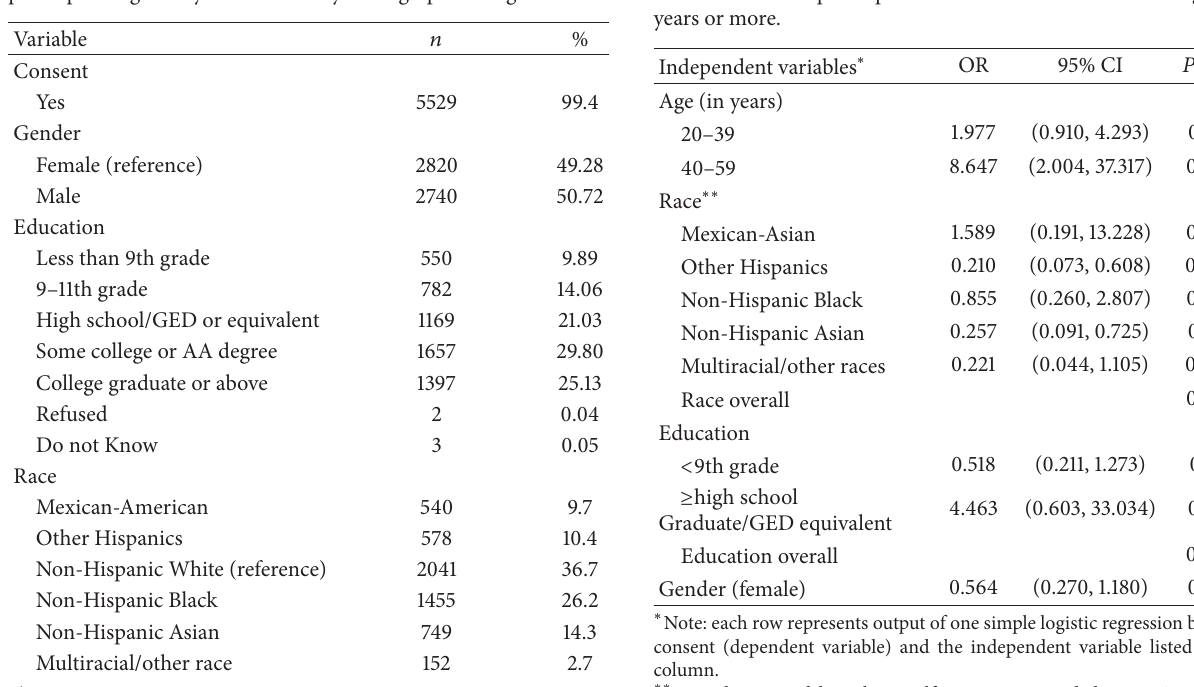
Table 1: Consent to biospecimen research among 2012 NHANES participants aged 20 years or more by demographic categories.